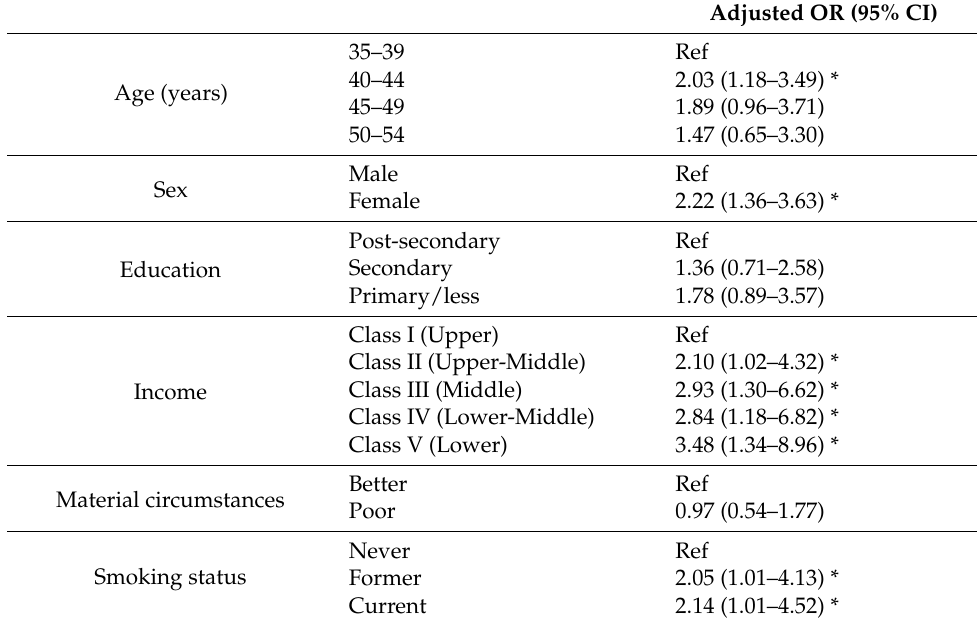
Table 3. Multivariable logistic regression model † evaluating various risk indicators of poor self-rated oral health among adults in rural